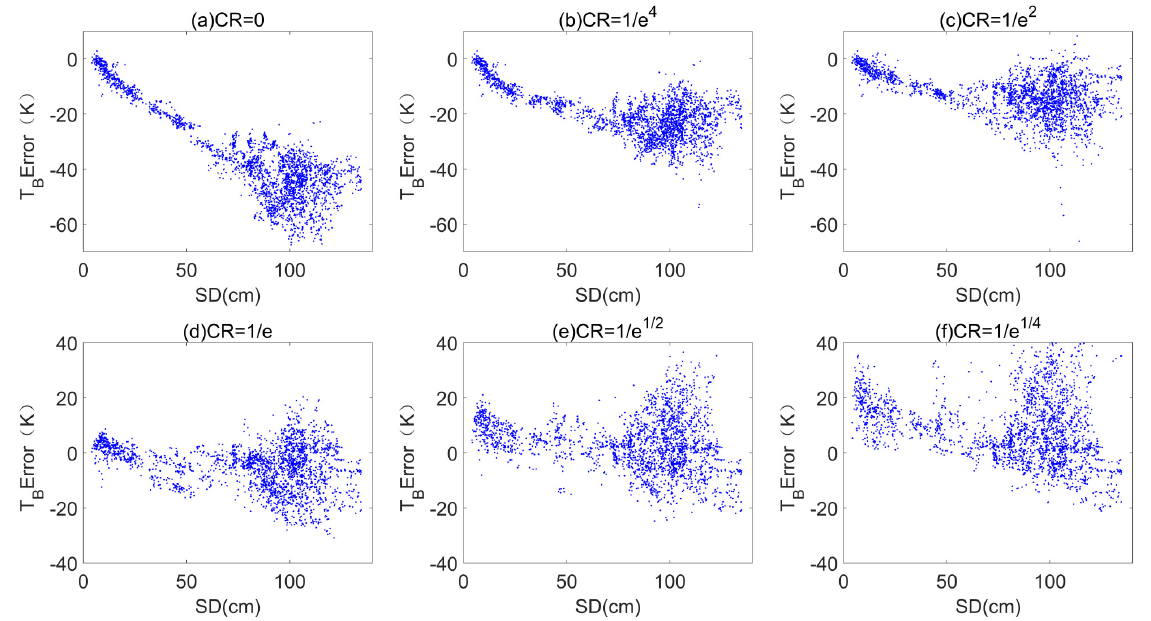
Figure 15. Sensitivity of brightness temperature (T B ) Error to snow depth (SD) using different penetration depth cut-off thresholds (CR) at 89 GHz, vertical polarization and a 55° incidence angle.